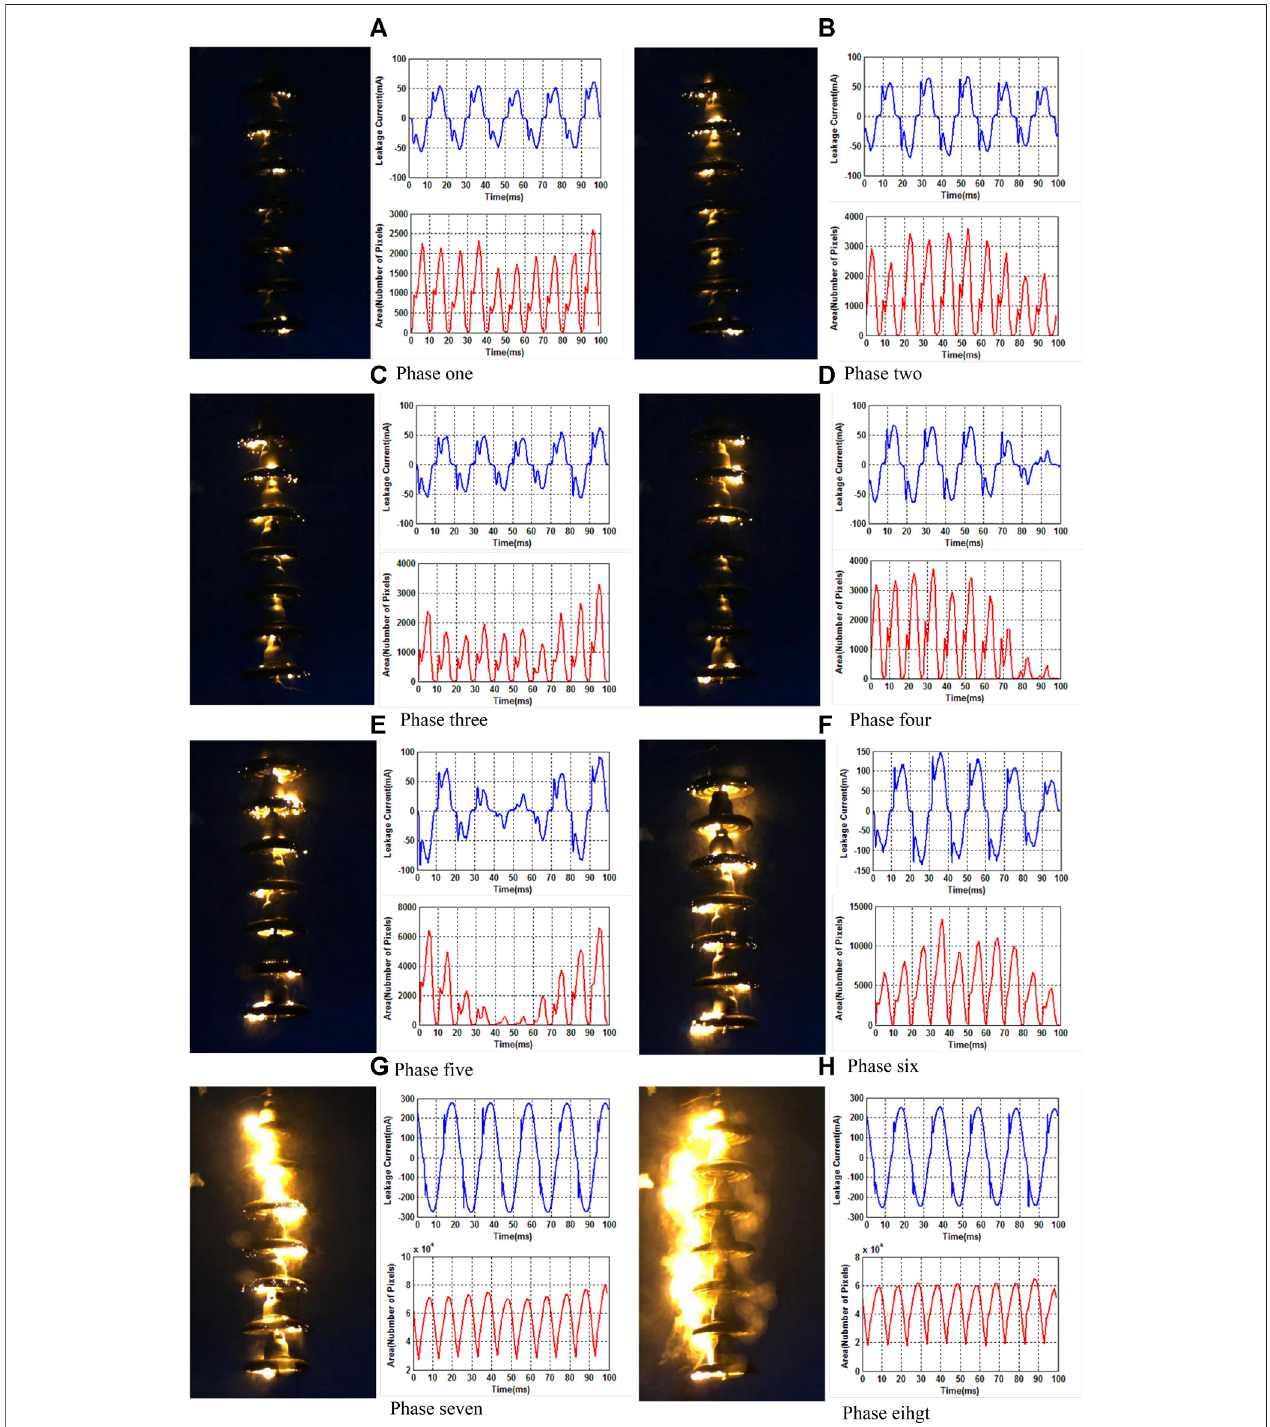
FIGURE 5 | Leakage current waveform and the arc